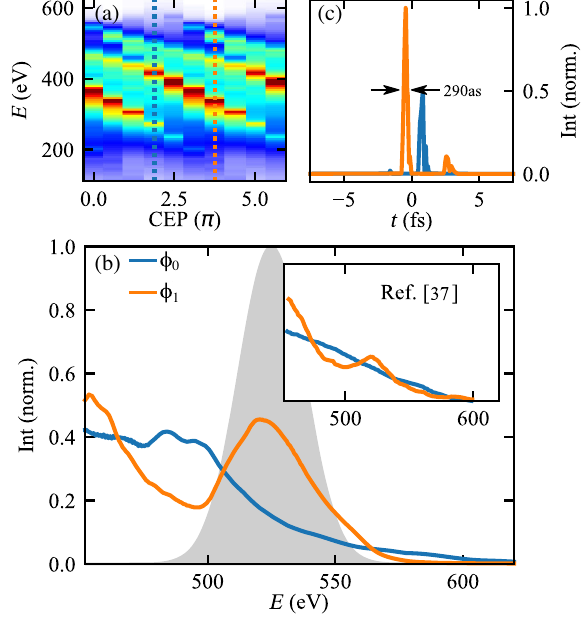
FIG. 5. Simulated CEP variation and isolated attosecond pulse generation for helium for the same conditions as in Fig. 4 but scaled to a driving wavelength of 1800 nm and at p ¼ 2000 mbar. (a) CEP-resolved spectra. Transmission through a 0 . 1 - μ m aluminum foil has been included to filter out the low-energy contribution. The color bar is the same as in Fig. 1. (b) XUV spectra near the cutoff for two different CEP values ϕ 0 and ϕ 1 as indicated in panel (a). The inset shows the data from Ref. [37]. The isolated attosecond pulses, generated in the energy window illustrated by the gray area, are shown in panel